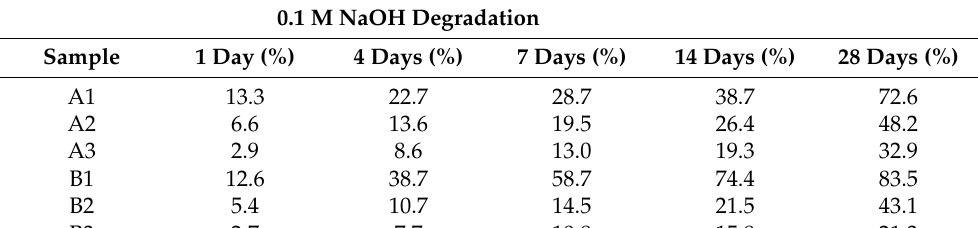
Table 5. Degradation degree of the produced porous microspheres in 0.1 M NaOH.